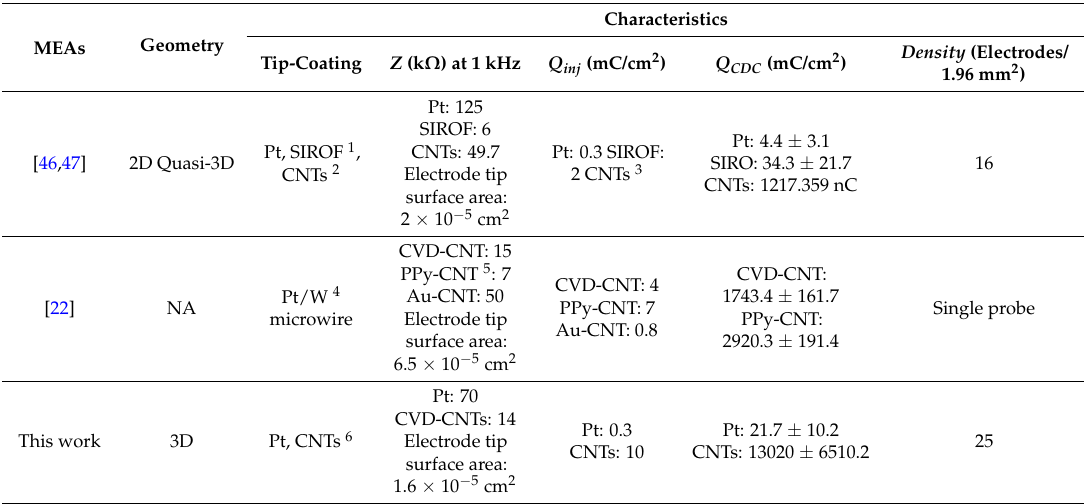
Table 4. Comparison of penetrating neural